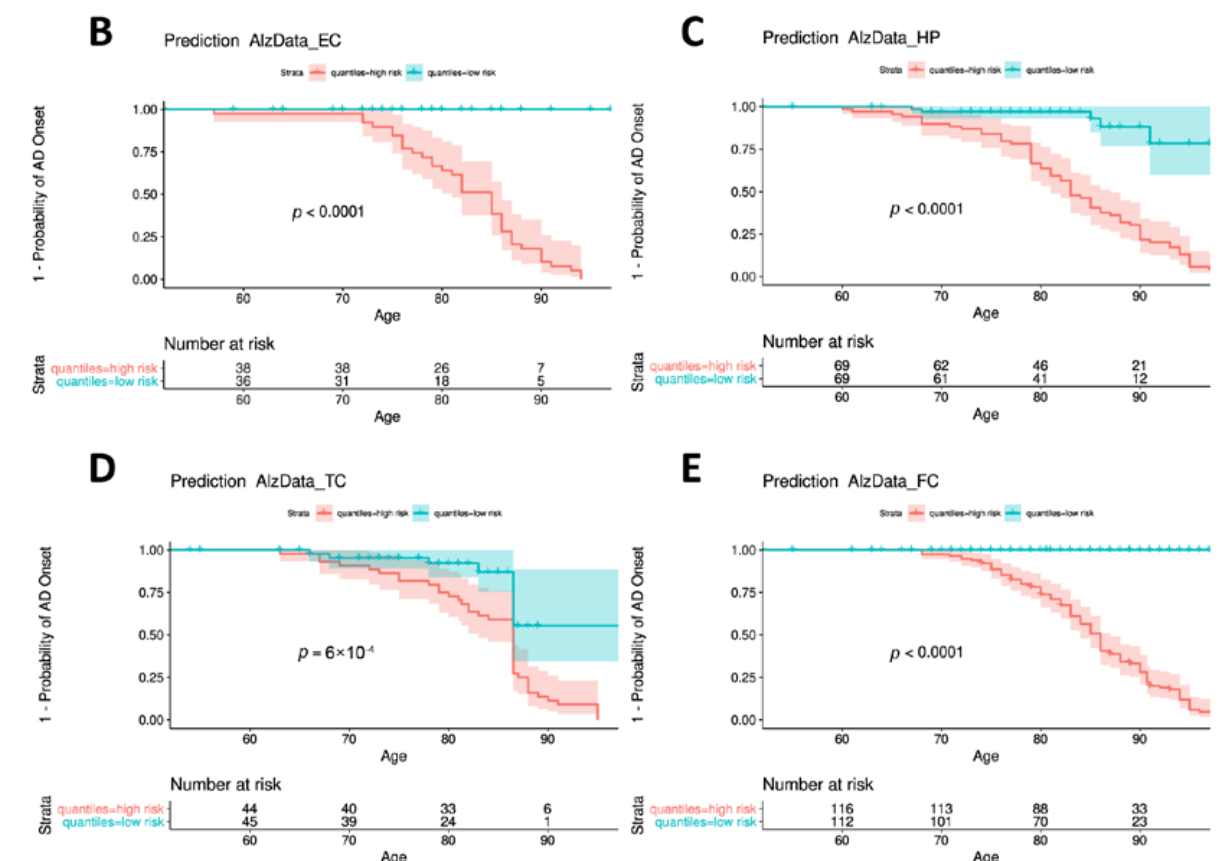
Figure 5. Construction and evaluation of AD predictive models based on AlzData. ( A )